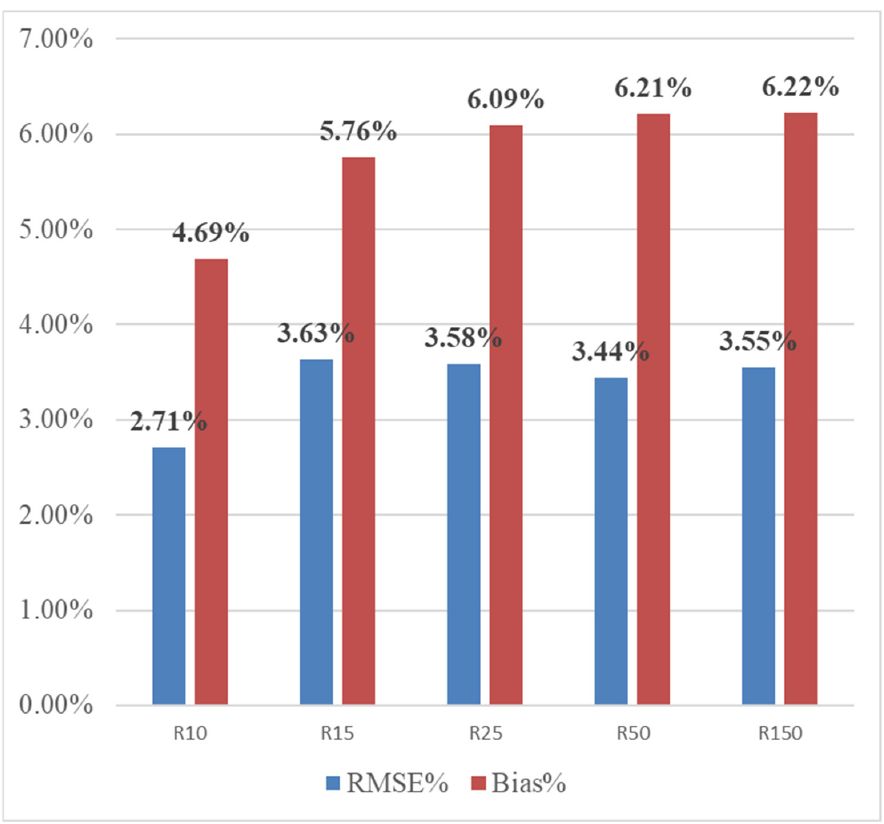
Figure 8. Difference in the accuracy of D. pierrei height among different stands.